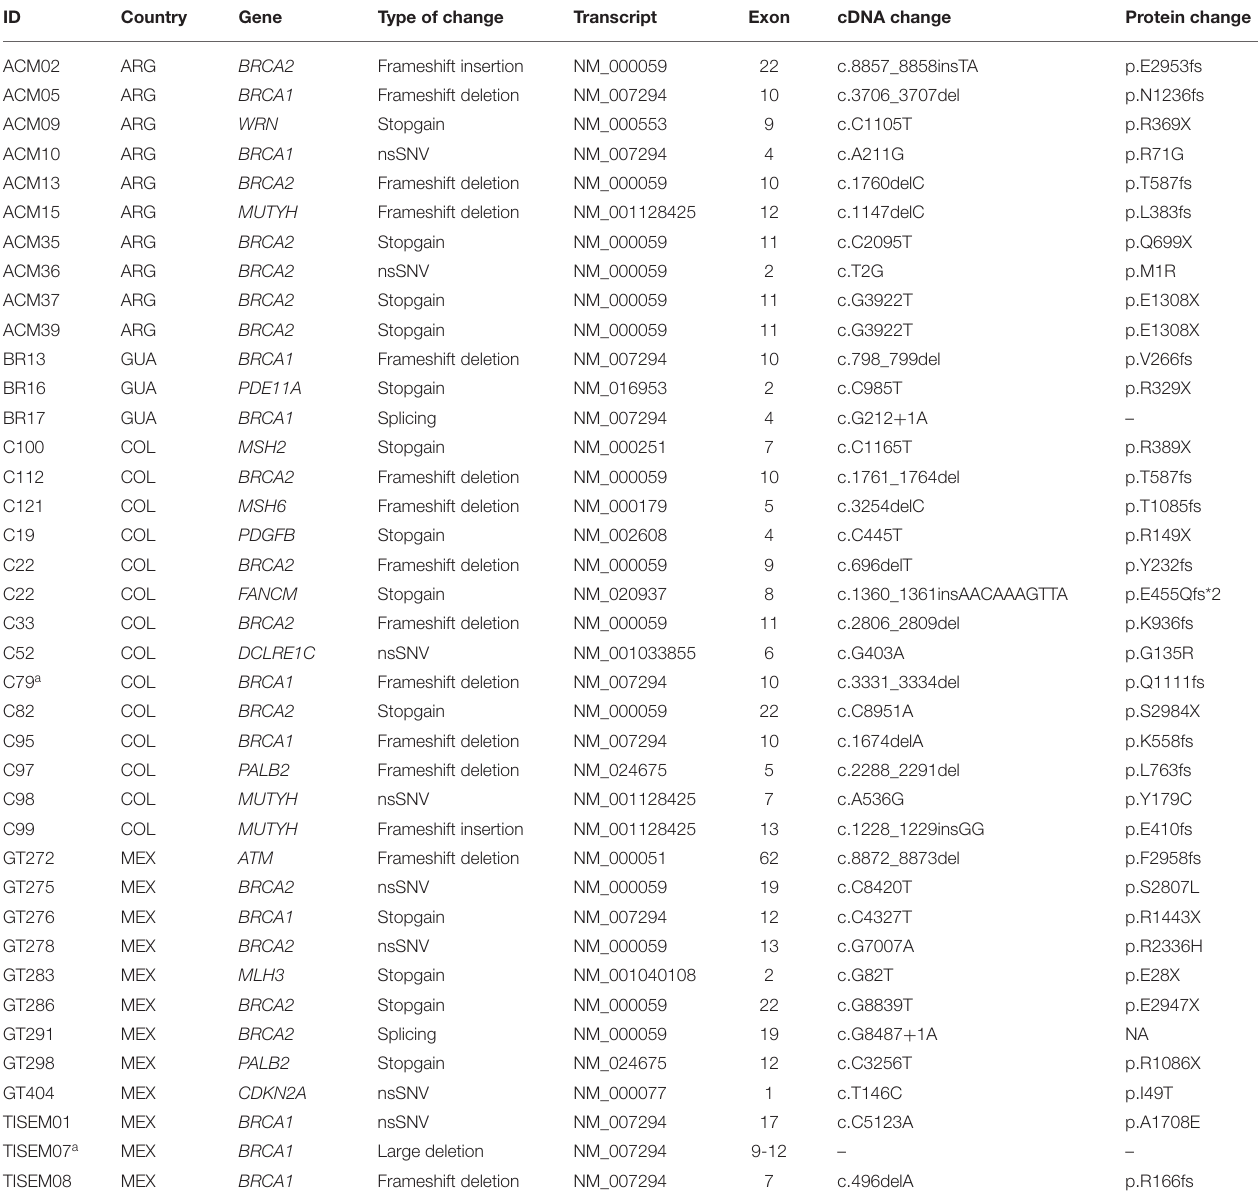
TABLE 3 | Pathogenic variants detected in 222 HBOC individuals from 4